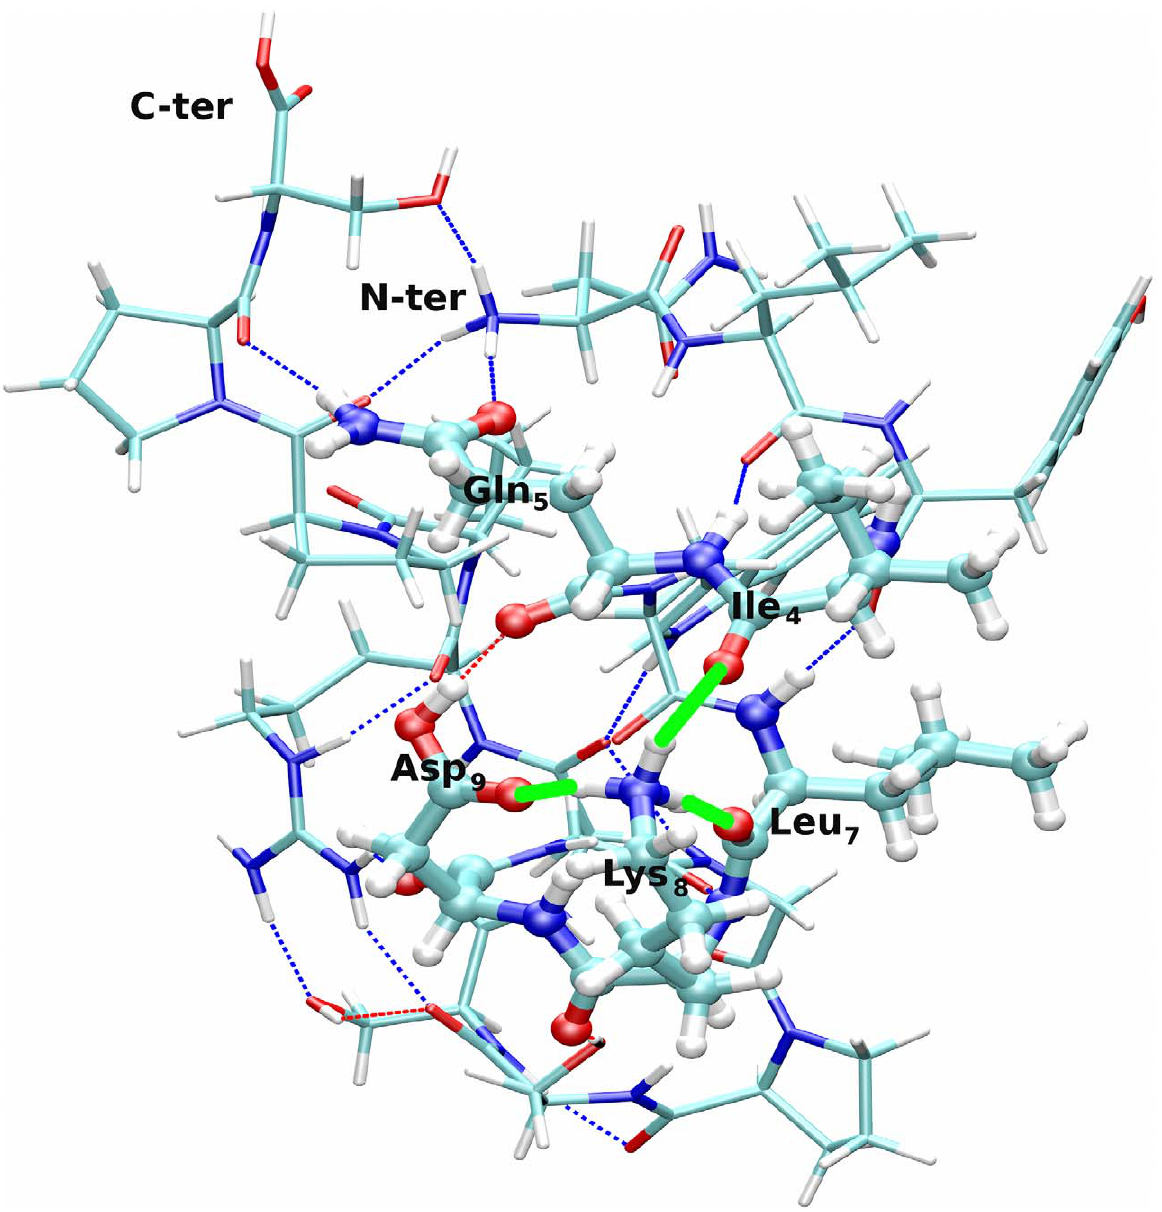
Figure 1. Ball-and-stick representation of the structure of the lowest-energy protomer trp ( 3 z ) ½ n z Q 5 K z The H-bonding network of protonated Lys 8 is shown as green lines; other H-bonds are shown as dotted lines.